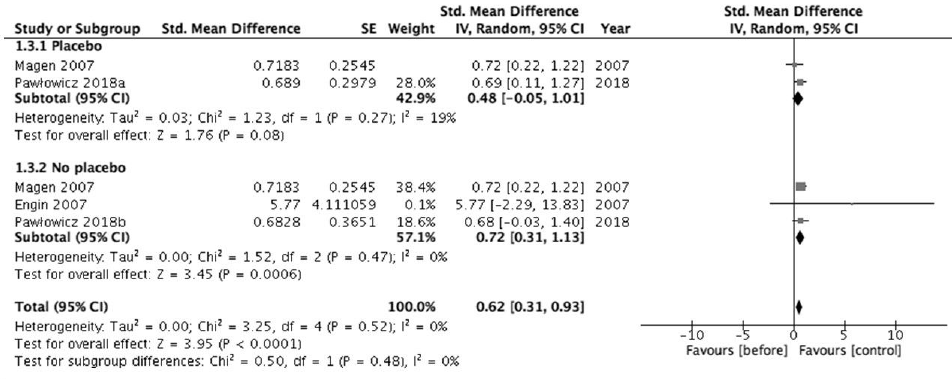
Figure 4. Forest plot of the clinical improvement in